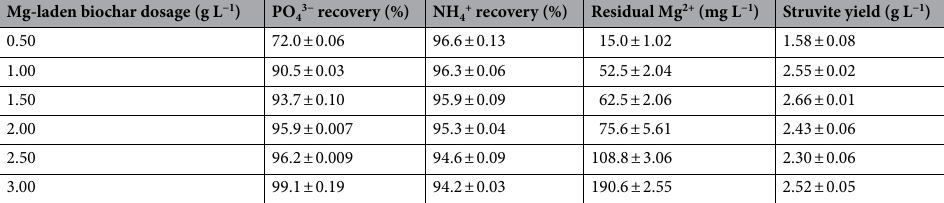
Table 1. Optimization of Mg-laden biochar dosage for enhanced PO 43− , and NH 4+ recovery and struvite yield.